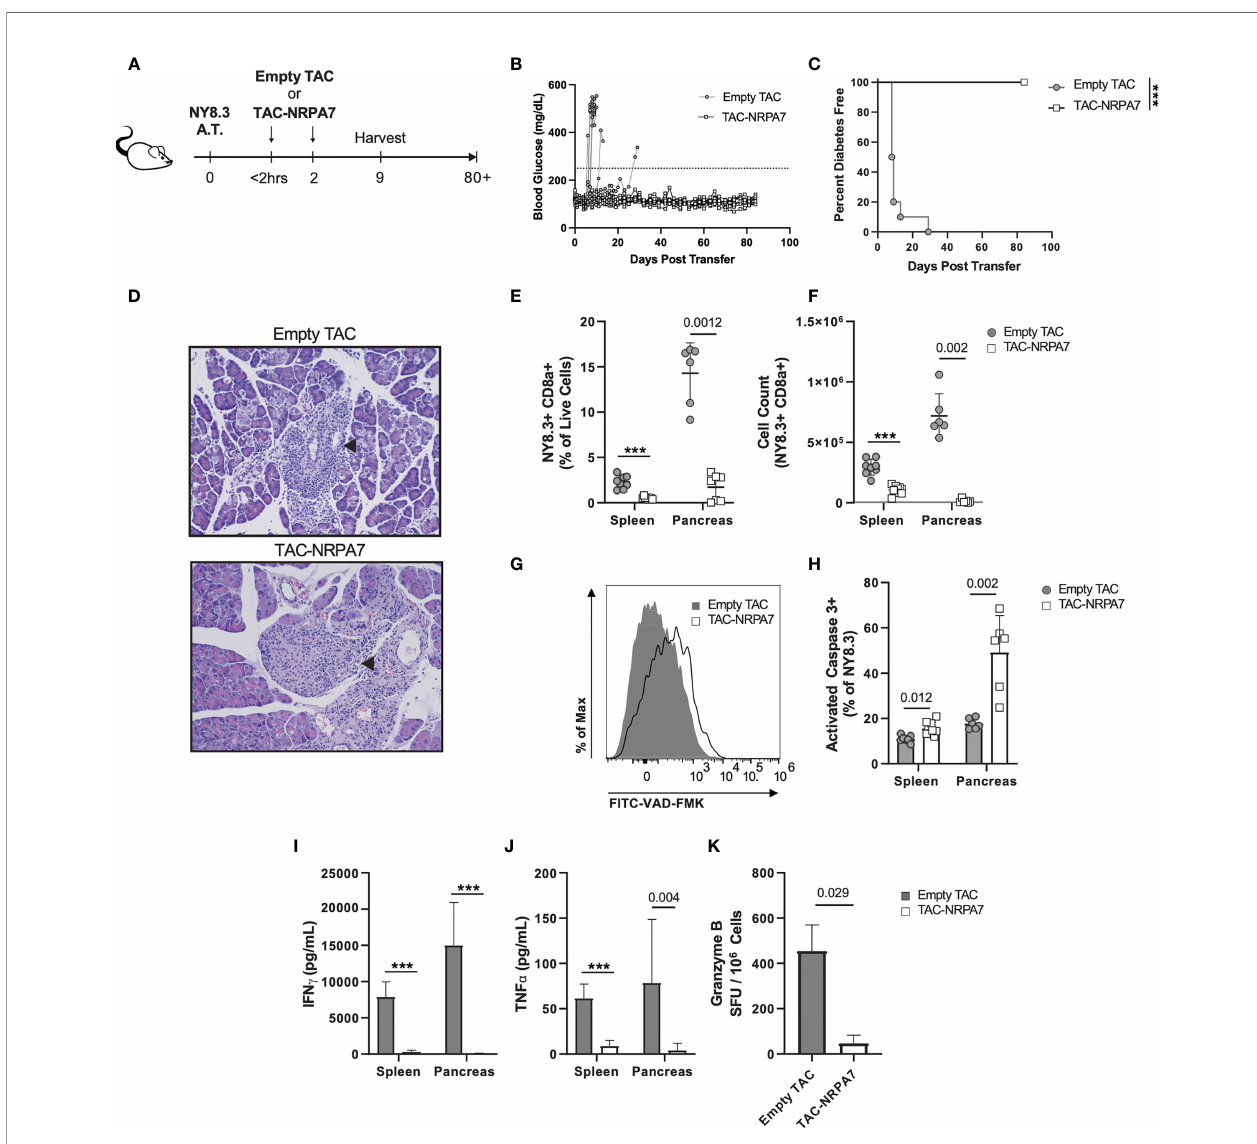
FIGURE 6 | TAC-NRPA7 prevents diabetes induced by NY8.3 T cells by deleting antigen-speci fi c T cells. (A-K) 7x10 6 activated NY8.3 cells were transferred into NOD. scid mice on day 0. 1x10 9 empty TAC or TAC-NRPA7 (200 m M squeeze) were dosed within 2 hours and on day 2, and (E-K) phenotype was assessed on day 9. (B) Blood glucose and (C) diabetes disease incidence of mice treated with empty of NRPA7 loaded TACs. (B, C) Disease was de fi ned as two consecutive days ≥ 250mg/dL (dotted line). n = 10 per group. Log-rank (Mantel-Cox) test. (D) Representative H&E staining of pancreata. Arrowhead indicates islet of Langerhans. n = 2 per group. (E) Frequency and (F) number of NY8.3 cells (CD90.2 + CD8 a + NRPA7 tetramer + ) in the indicated organs. (G) Representative activated caspase 3 (FITC-VAD-FMK) staining of splenocytes and (H) quanti fi cation in the indicated organs. Gated on NY8.3 cells irrespective of fi xable viability stain. (I) IFN g and (J) TNF a secretion by NRPA7 stimulated cells from indicated organs. (E-J) Spleen n = 7-9, pancreas n = 6 pools per group. Data from 2 independent experiments. (K) ELISpot of Granzyme B producing splenocytes after stimulation with NRPA7 peptide. n = 4 pools per group. (E-K) Each symbol is a pool of 2-4 animals. Mean +/- SD. Mann-Whitney U Test. (A-K) *** P <